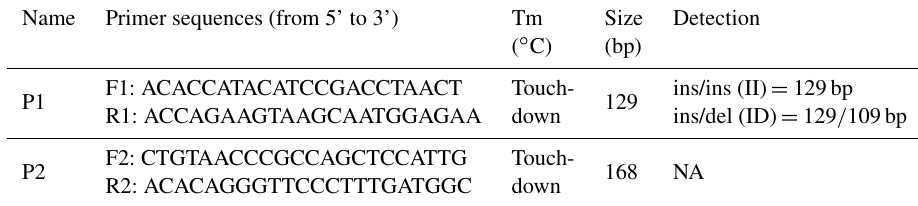
Table 1. Amplification PCR primer sequences of CDC25A goat gene.